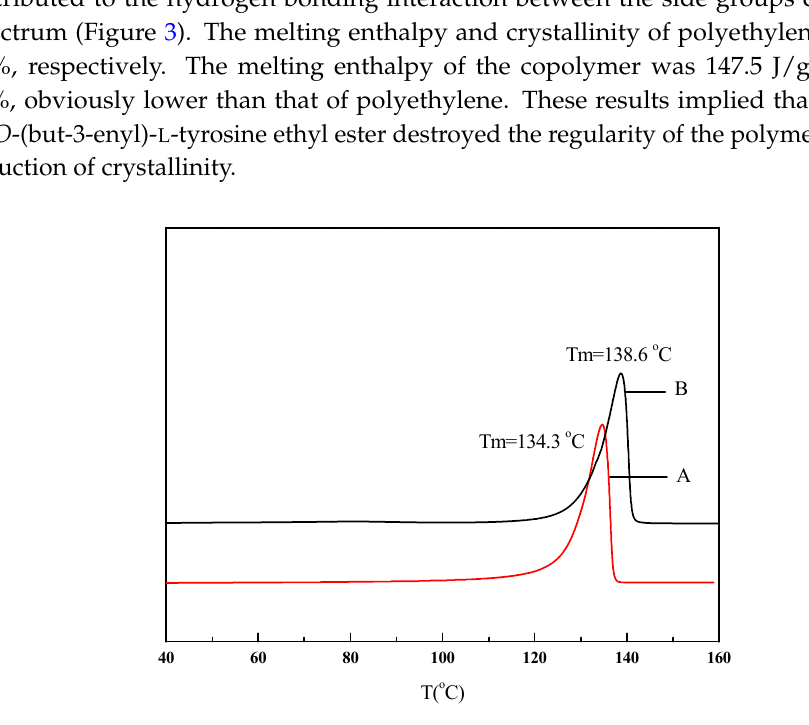
Figure 4. DSC spectra (the second heating) of ethylene homopolymer ( A , run 1 in Table 1) and ethylene/ N -acetyl- O -(but-3-enyl)- L -tyrosine ethyl ester copolymers ( B , run 3 in Table1).